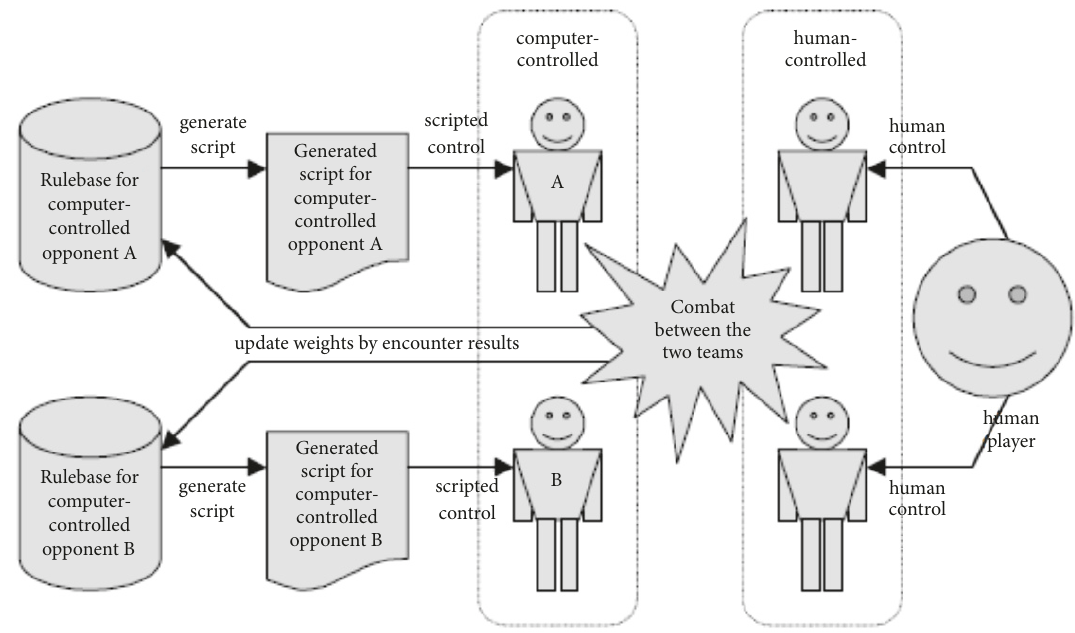
Figure 6: The dynamic scripting process.